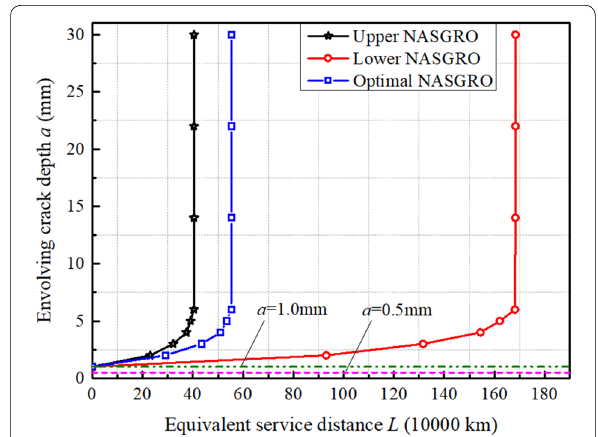
Figure 15 Predicted life of brake unit bracket with an initial crack of 2 mm